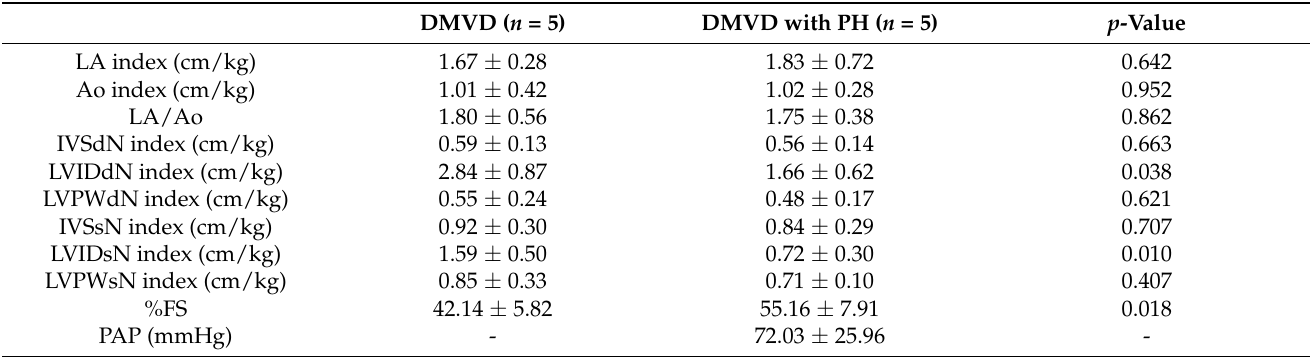
Table 3. Echocardiographic data of dogs in degenerative mitral valve disease (DMVD) and degenera- tive mitral valve disease with pulmonary hypertension (DMVD with PH) groups.